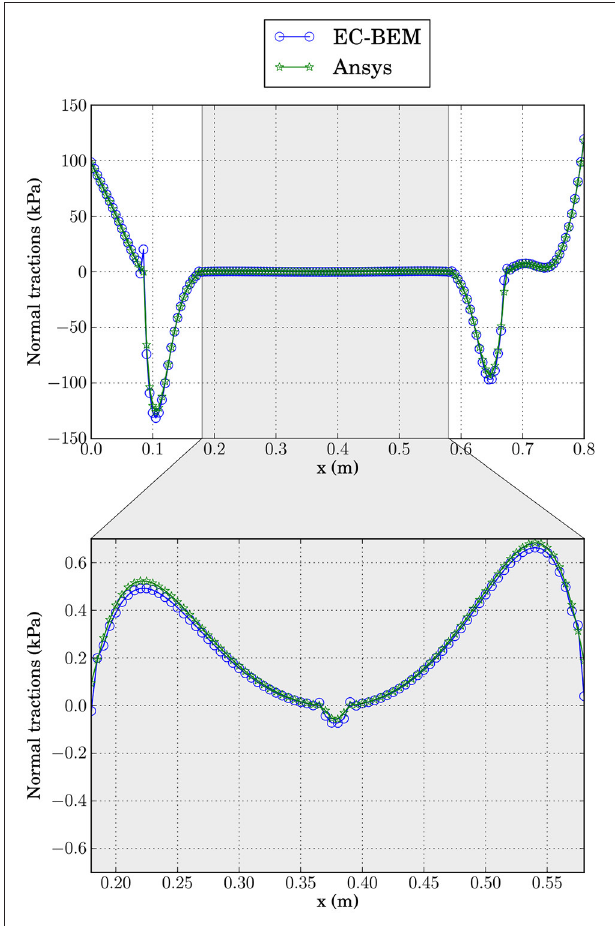
FIGURE 21 | Comparison of the normal tractions computed by EC-BEM and ANSYS for the adhesive elastic contact, with u D = 0.035 mm.